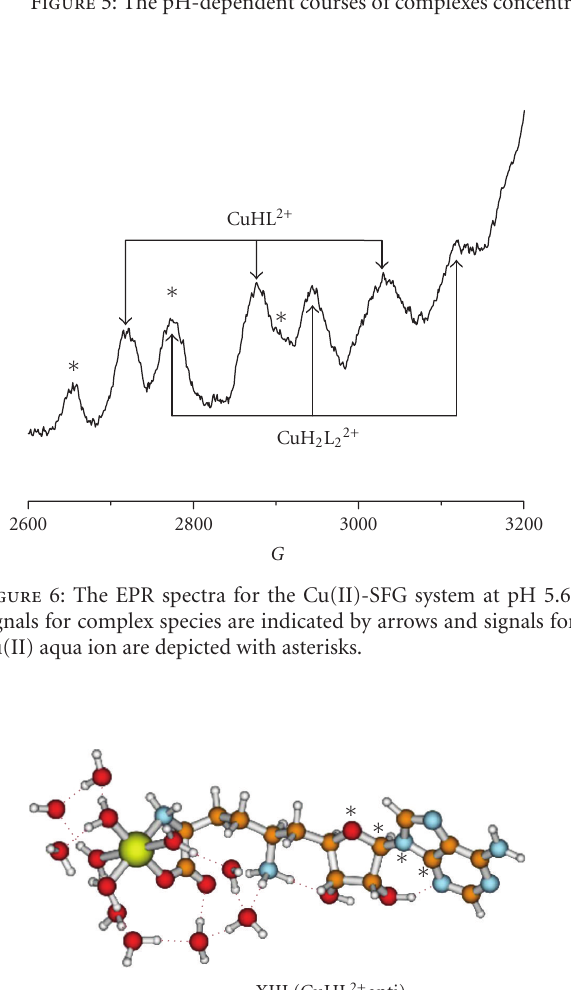
Figure 5: The pH-dependent courses of complexes concentrations and the (a) CD and (b) UV-Vis spectra parameters overlaid.